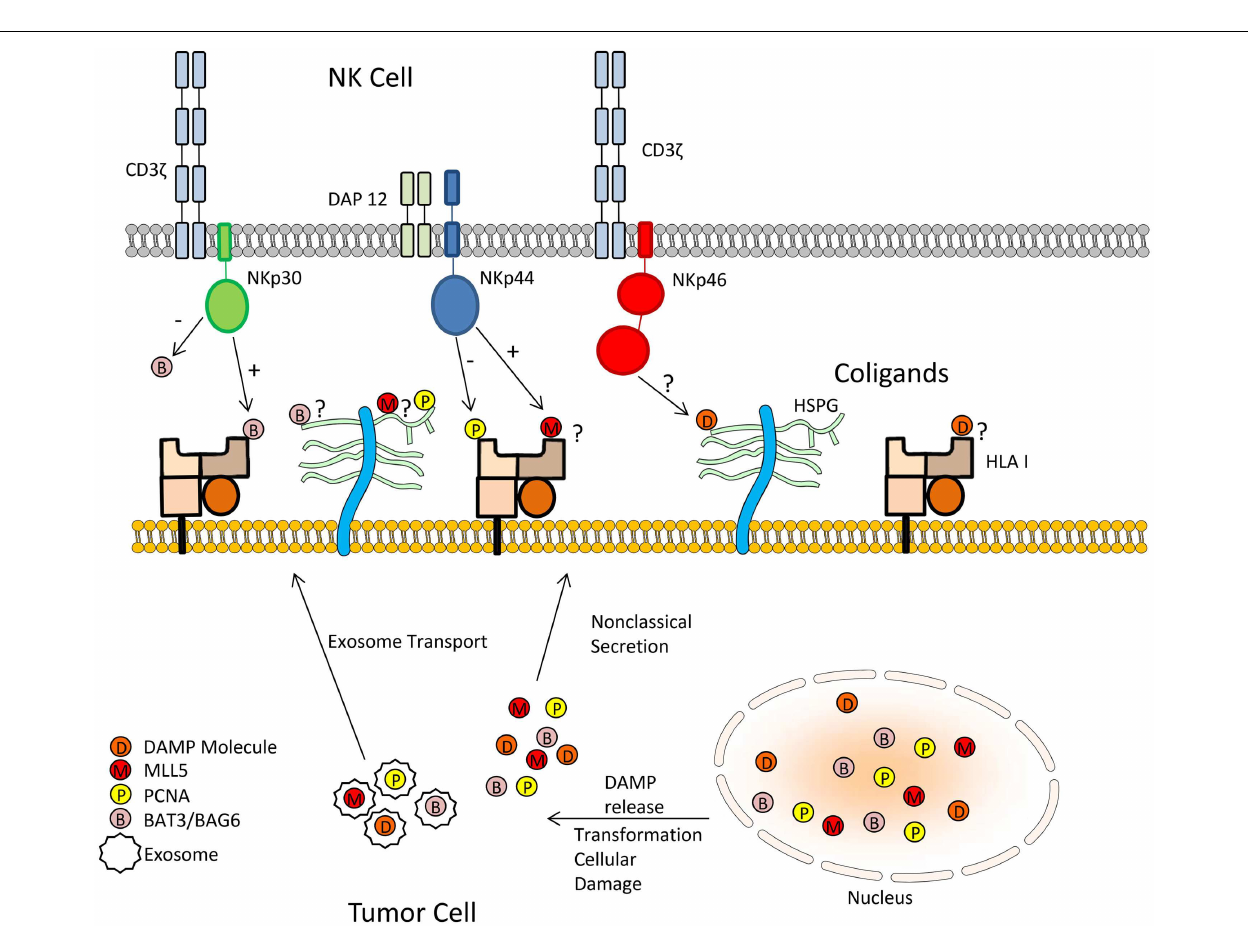
FIGURE 1 | Mechanism by which tumor cells may inhibit natural cytotoxicity through NCR recognition by DAMPs .The association of DAMPs with HSPGs, HLA I, or other potential co-ligands may form larger complex ligands for the members of the NCR